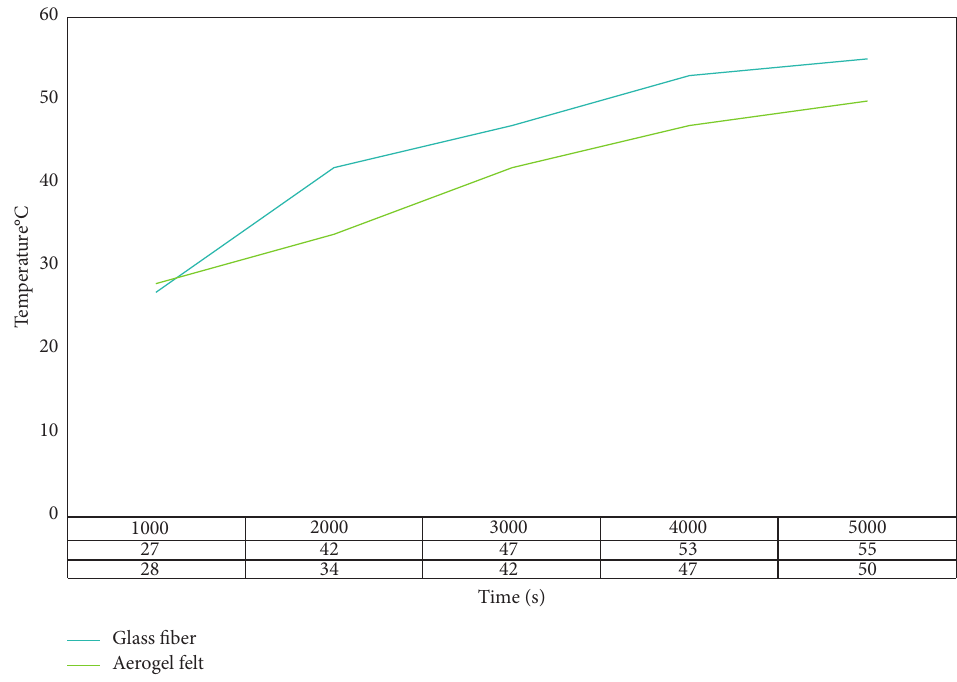
Figure 5: Variation curve of the test temperature of the concrete slab with time.